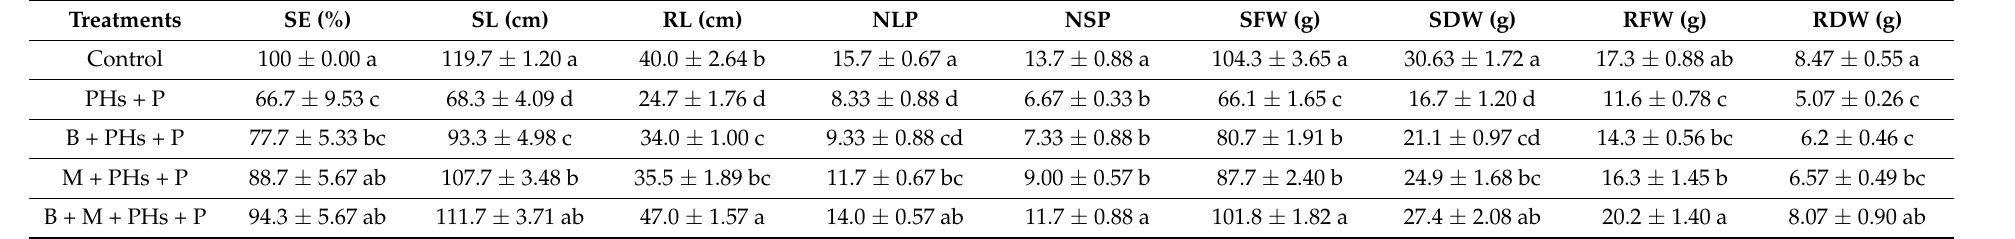
Table 1. Effect of biochar and Bacillus sp. MN54 on agronomic attributes of maize plants grown in diesel contaminated soil.